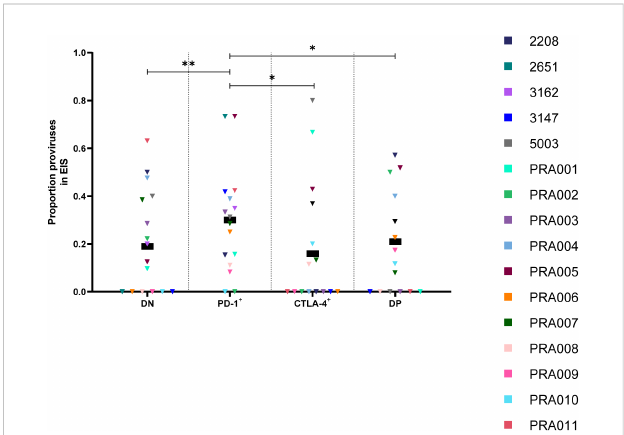
FIGURE 5 Proportion of HIV-1 proviruses found in an expansion of identical sequences (EIS) in peripheral blood memory CD4 + T-cells expressing PD-1 and/or CTLA-4. The proportion of ampli fi ed HIV-1 proviruses that were part of an EIS in DN, PD-1 + , CTLA-4 + and DP cells. Data is the estimated proportion for each subset. P-values represent evidence for an overall trend of a difference between subsets within these participants (mixed effects logistic regression), * p ≤ 0.05, ** p ≤